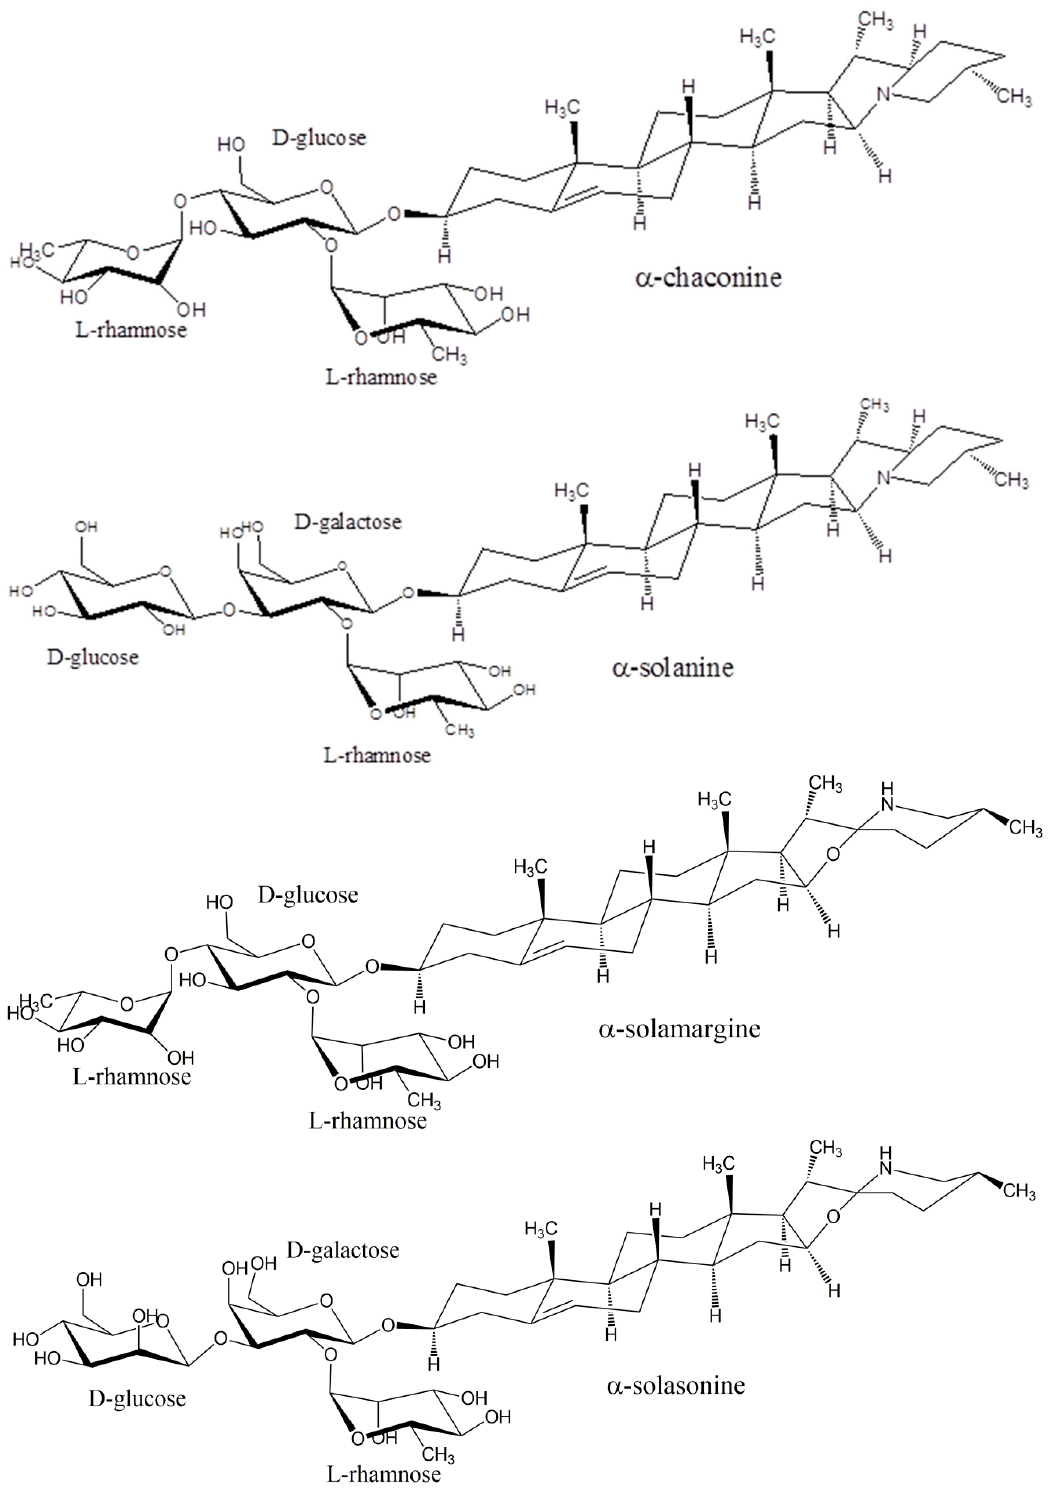
Figure 1. Structures of the glycoalkaloids α -tomatine, α -chaconine, α -chaconine, α -solamargine, and α -solasonine.